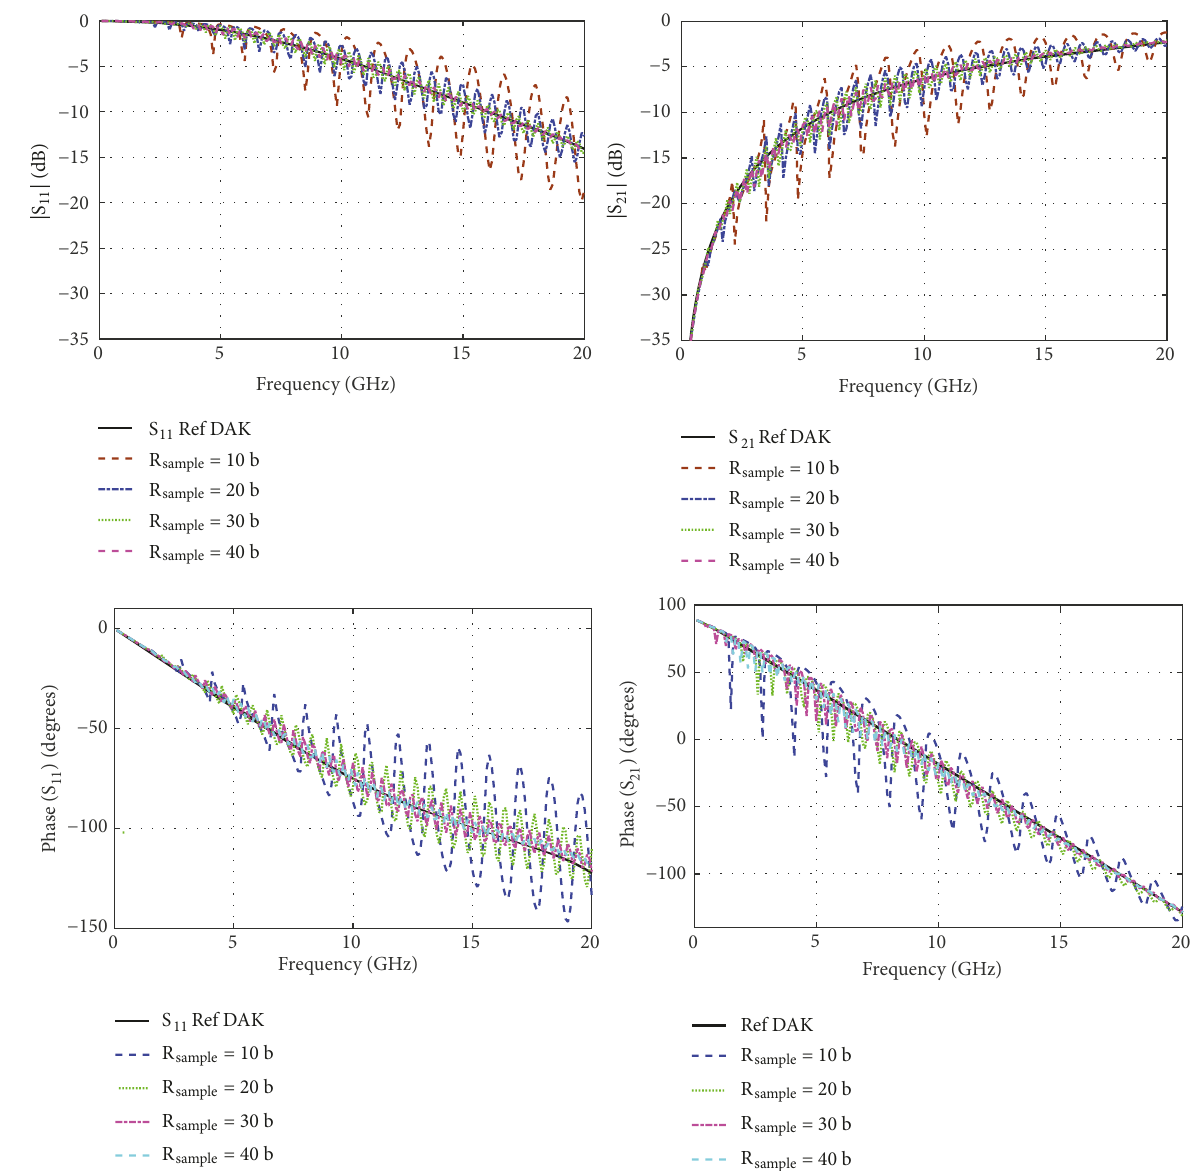
Figure 13: Magnitude (dB) and phase (degrees) of S 11 and S 21 for model A3 with TEM and TM 0 different values of the virtual circular waveguide containing the sample (thickness of d